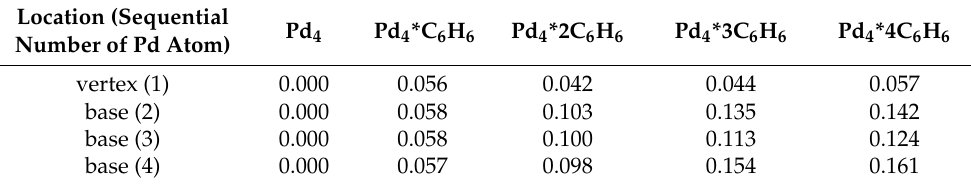
Table 3. Löwdin charges of Pd 4 and Pd-BZ adsorption complexes.